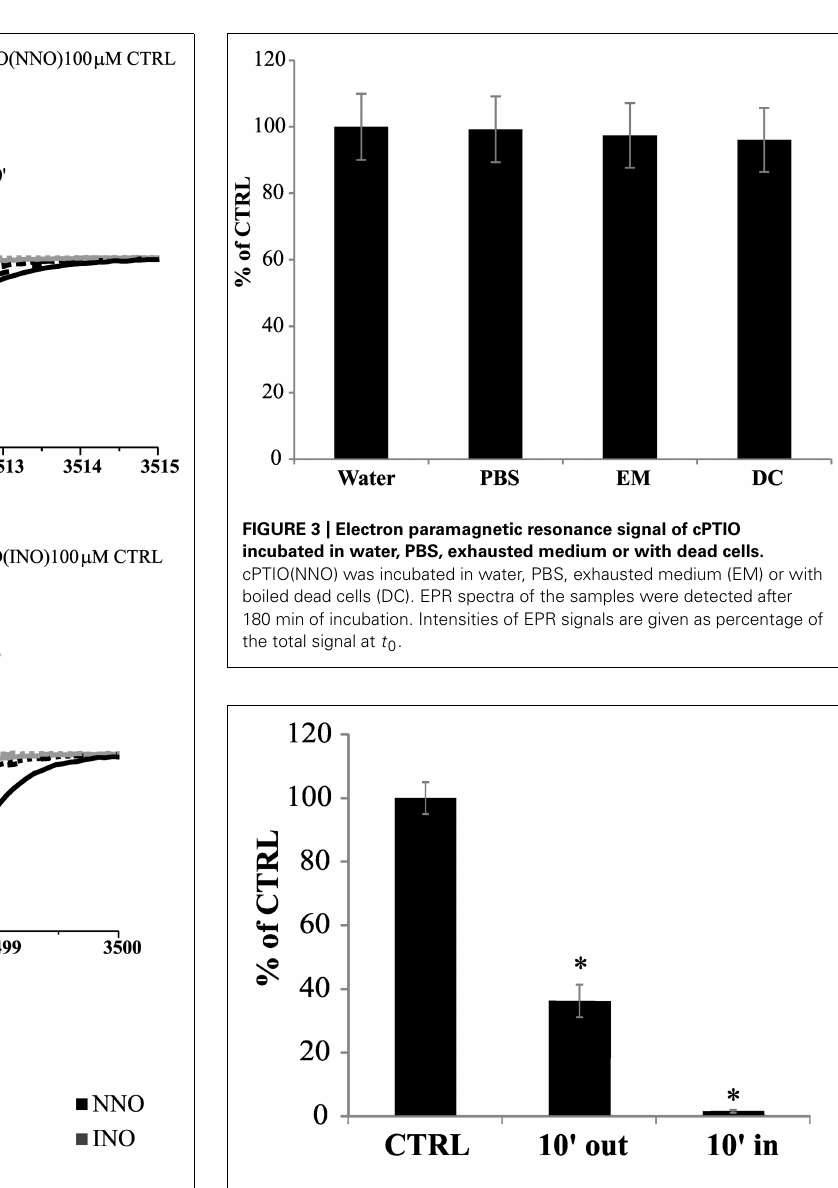
FIGURE 4 | cPTIO uptake in cell cultures. cPTIO(NNO) was incubated with cell cultures. At 10 min a sample from the culture medium was collected (10 (cid:2) out) and all cells were harvested.The cells were disrupted and centrifuged. An aliquot of the supernatant was collected (10 (cid:2) in). EPR signals were detected and given as percentage of the total signal resulting from measurement of 100 μ M cPTIO(NNO) dissolved in water (CTRL) ± SD. A Student’s t -test was performed and samples statistically different from the CTRL marked with an asterisk small cPTIO(NNO) signal was detected also in the cell extract, showing that cPTIO was actually entering the cells but its con- centration resulted strongly reduced when compared to the bulk concentration initially added to the sample (about 1% of the sig- nal of 100 μ M cPTIO in water; Figure 4 ). This result proves that the decrease of the EPR signal observed in the medium is not due to the spin trap accumulation inside the cells, but rather to the disappearance of